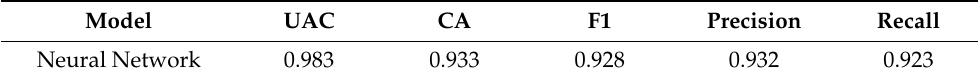
Table 3. Results for deep learning feasibility experiment with Orange platform and East Asian dataset.